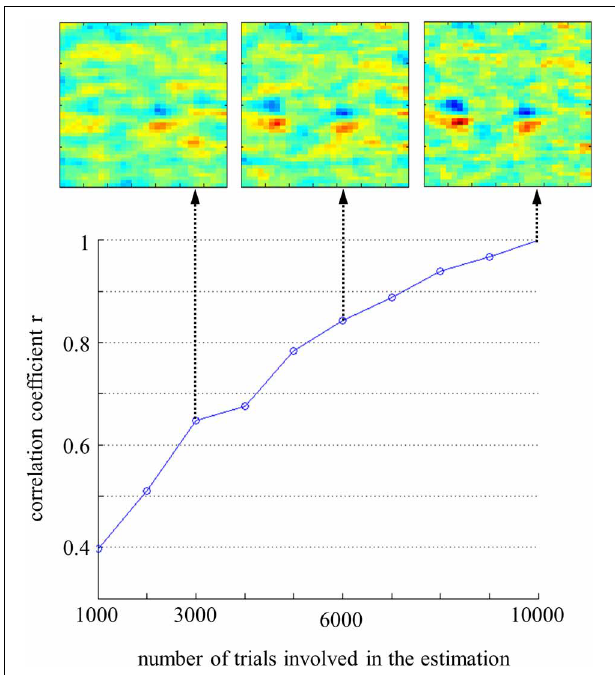
FIGURE 6 | Correlation between coefficients of the Classification Images estimated on n trials and the “overall” Classification Image, for participant MH. Examples of Classification Images are shown at 3000, 6000, and 10,000 trials.